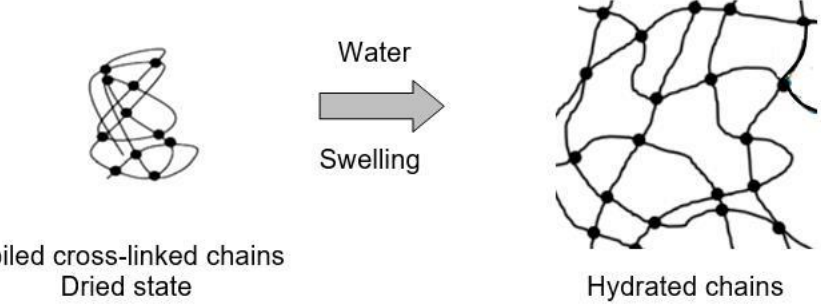
Figure 9. Diagrammatic representation of the part of the polymer network. Adapted with permission from [253]. Copyright 1997: Wiley.